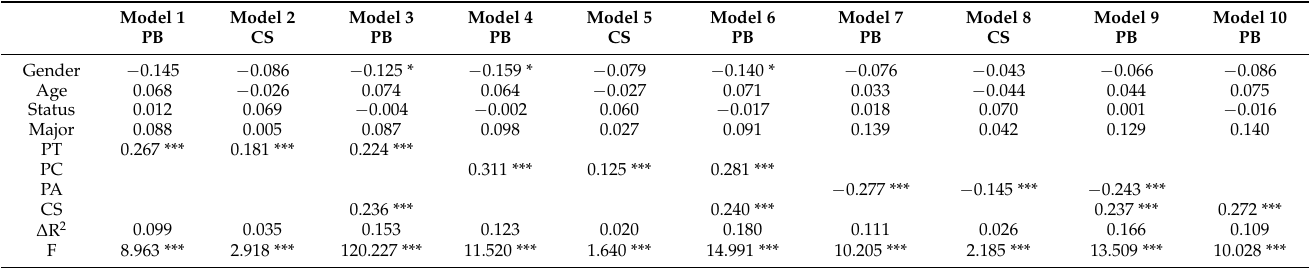
Table 2. Results of the hierarchical regression analysis (N =